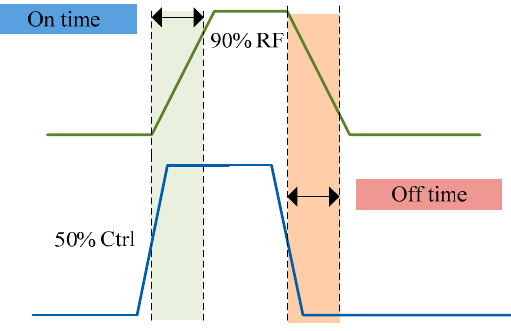
Figure 2. The definition of switching speed.